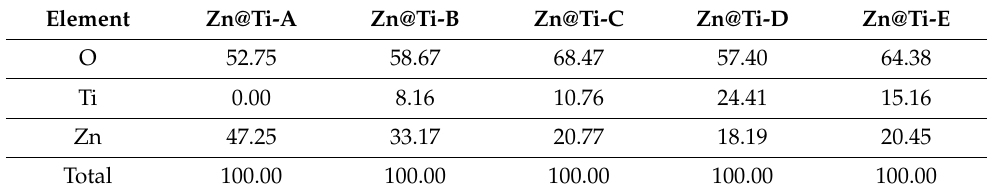
Table 1. Atomic percentage of plasma-synthesized oxide nanocomposites of zinc and titanium.